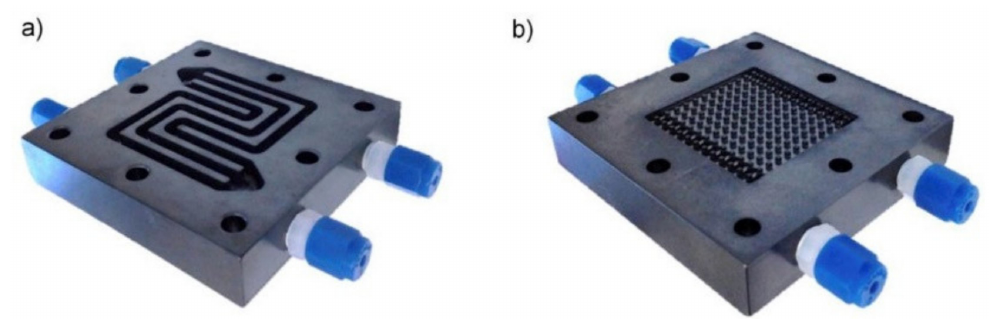
Figure 16. Bipolar plate made from PPS; ( a ) Reformer side, ( b ) Fuel cell side. (Adapted from [162], copyright 2017,